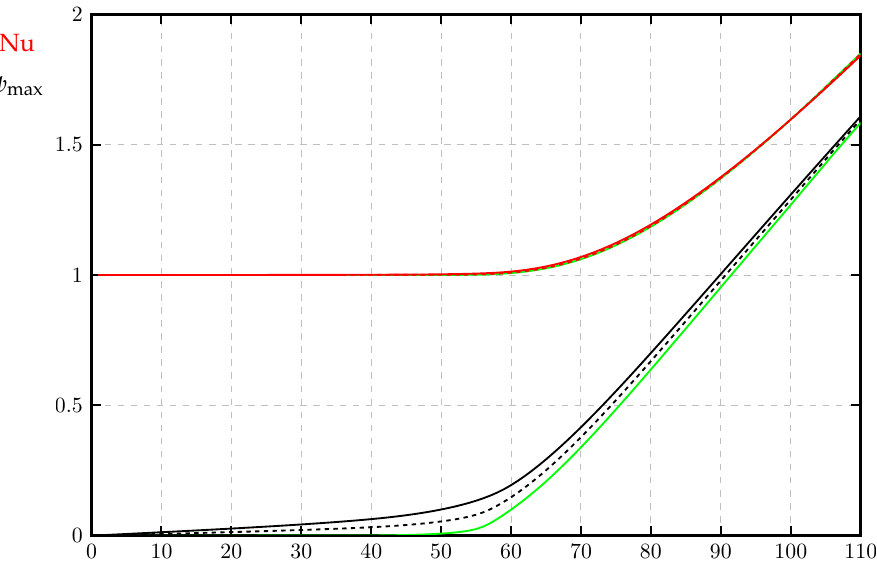
Figure A2. For the aspect ratio, A = 1.5, the variation with Ra of the maximum value of the streamfunction (black) and the Nusselt number, Nu (red) as Rb. Continuous lines correspond to c = 50 and dashed lines to c = 100. The green lines correspond to the respective extrapolates. The presumed linear dependence of Q on ( c + 1 ) − 1 is shown to be correct since the extrapolated form given by Equation (A2) is indistinguishable from the horizontal axis for subcritical values of Ra. It is interesting to contrast the linear variation of Q ( c = 50 ) and Q ( c = 100 ) at subcritical values of Ra, which is consistent with a Newtonian flow, and the quadratic variation of Q just above Ra = Ra c , which is characteristic of the Bingham fluid flow. On the other hand, there is very little difference between the three curves for